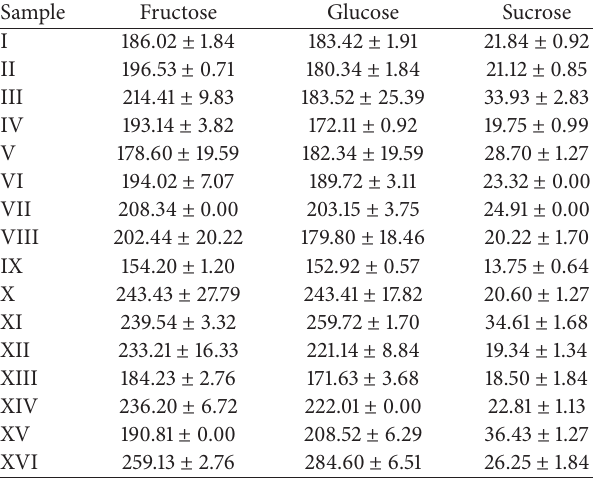
Table 4: Fructose, glucose, and sucrose contents (mgg −1 , mean values ± SD, 𝑛 = 3 ) in goji